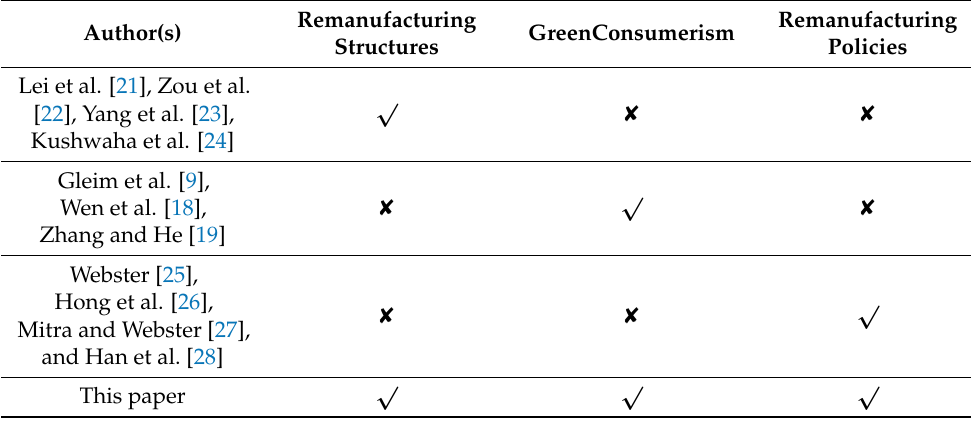
Table 1. Overview of this paper’s contribution to related